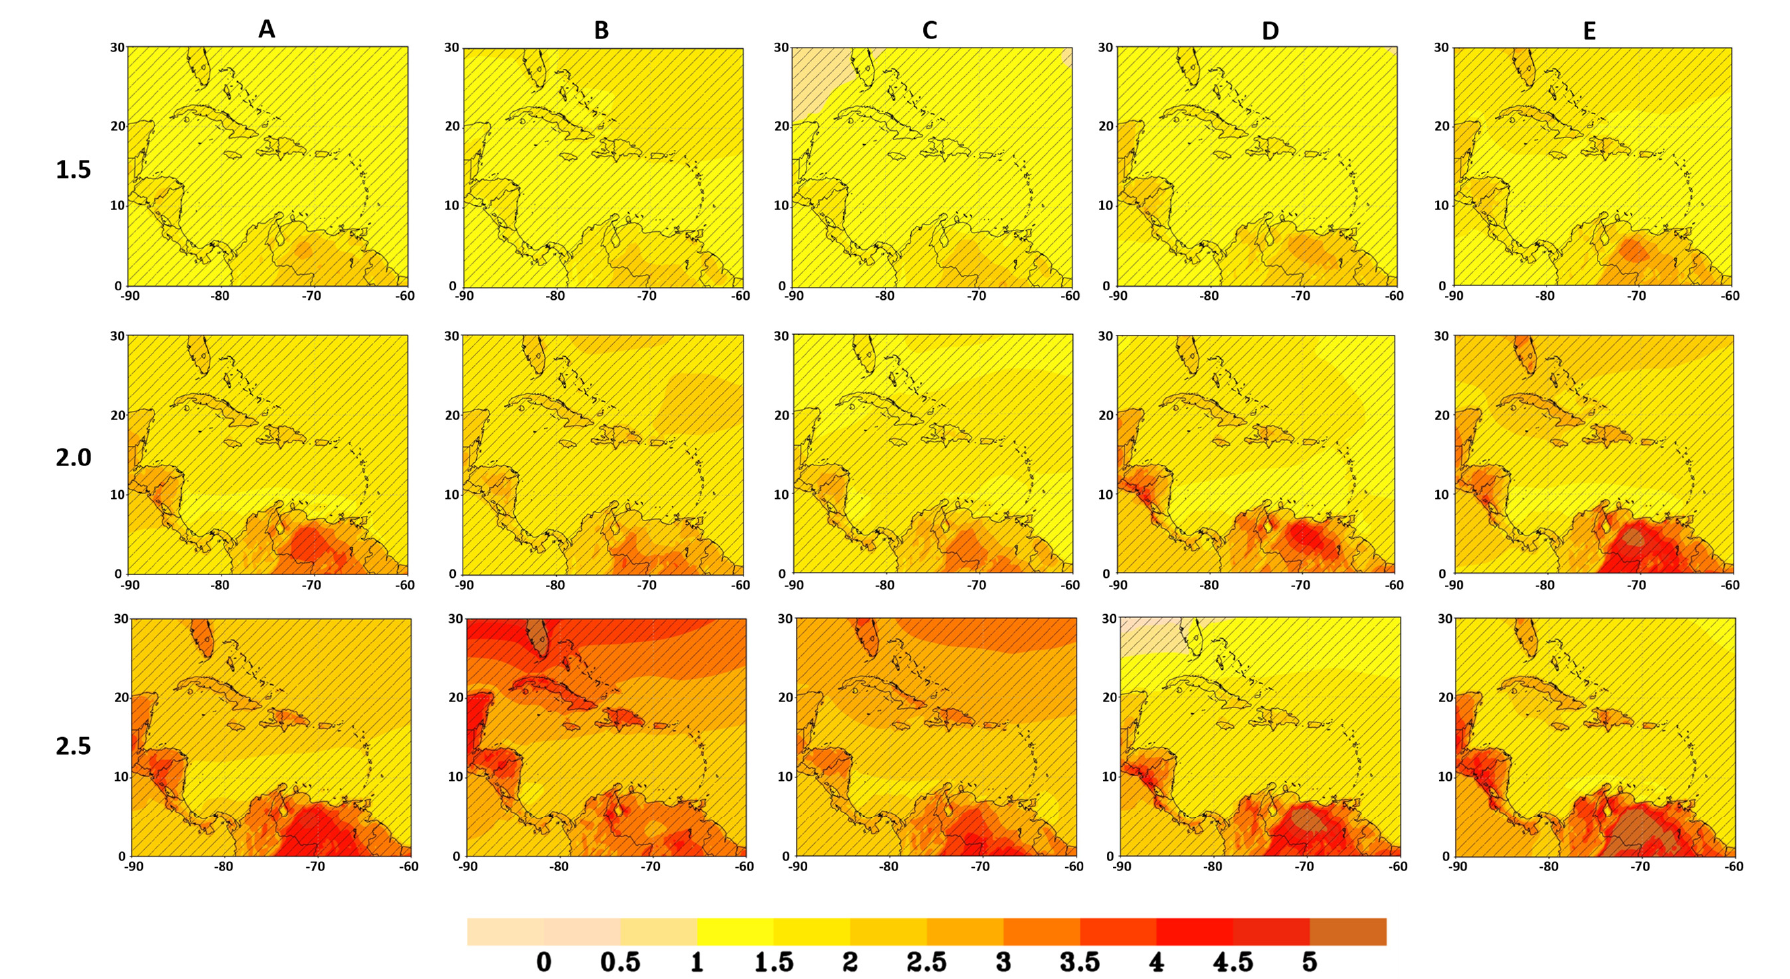
Figure 7. Diagram showing the projected absolute change in temperature (°C) for (column A) Annual (column B) NDJ, (column C) FMA, (column D) MJJ, and (column E) ASO for the 1.5 °C (row 1), 2.0 °C (row 2), and 2.5 °C (row 3) global warming thresholds. Results are from the ensemble mean of six perturbed physics simulations of the PRECIS RCM. Hashing indicates changes that are at the 95% significance level. All changes are with respect to a baseline period of 1960–1990.